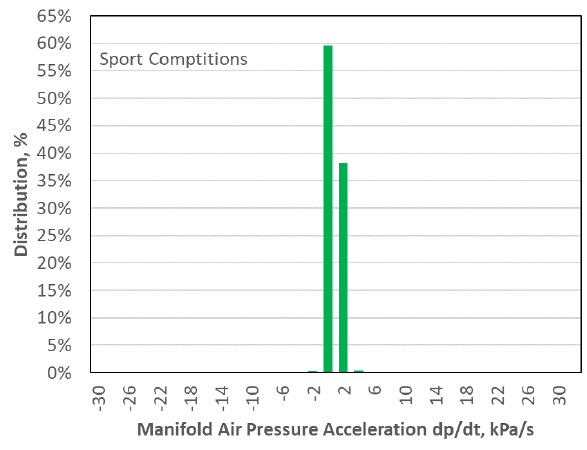
Fig. 13. Distribution of the rate of change of manifold air pressure during the sport